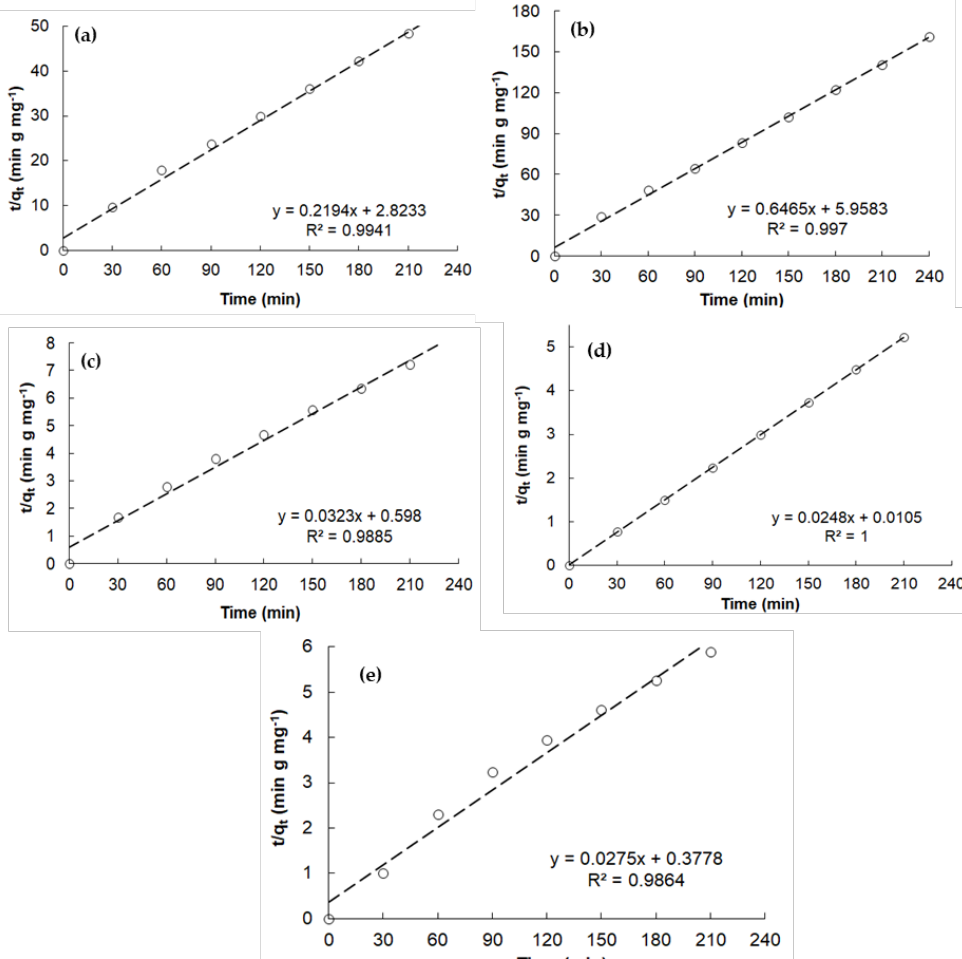
Figure 10. Pseudo − second-order kinetic model for: ( a ) RHB adsoption by LS at pH 3, ( b ) MB adsorption by LS at spontaneous pH, ( c ) RHB adsoption by P − LS at spontaneous pH, ( d ) MO adsorption by P − LS at spontaneous pH, ( e ) and MB adsorption by P − LS at spontaneous pH.